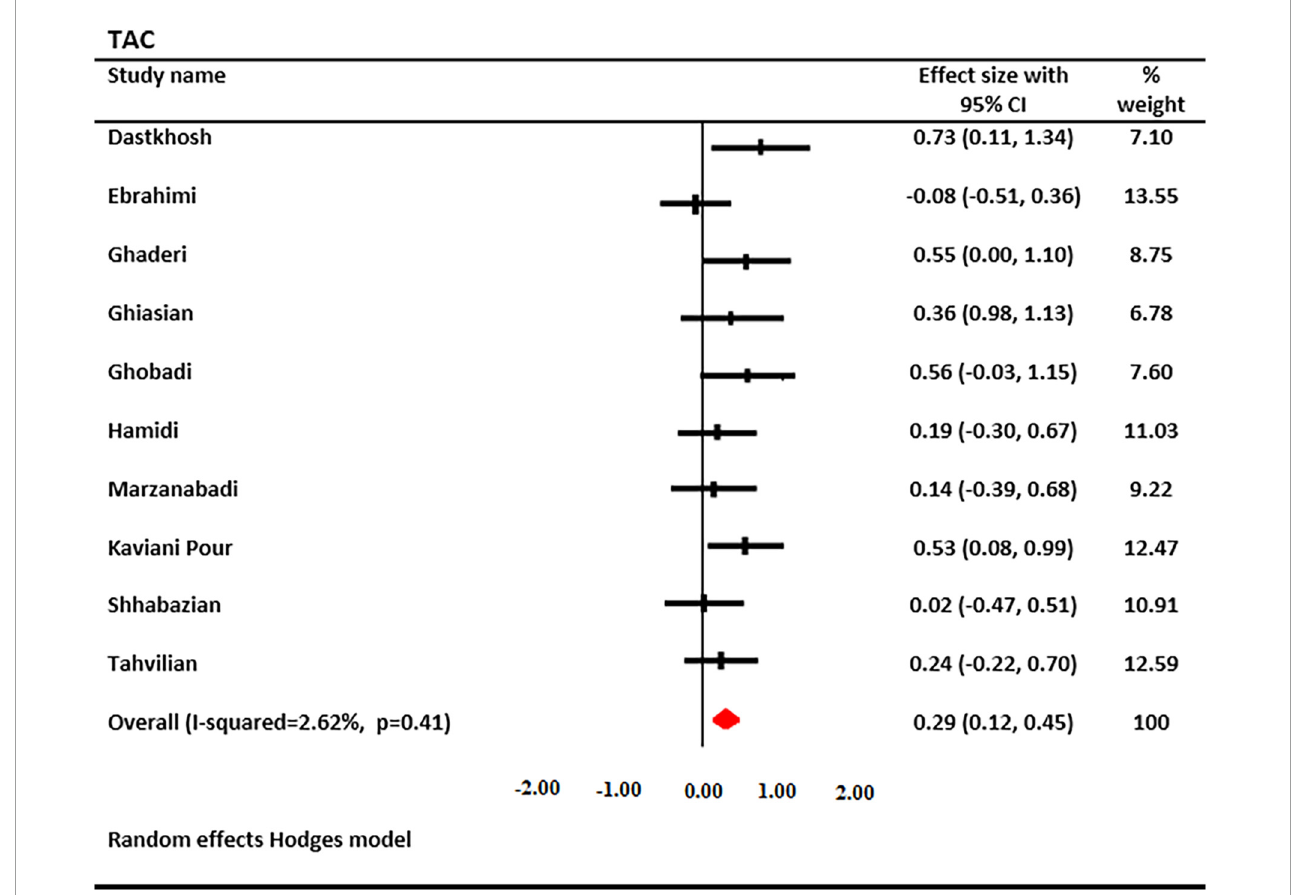
FIGURE4 Forest plot showing the summary effect size for total antioxidant capacity (TAC) levels between saffron and placebo